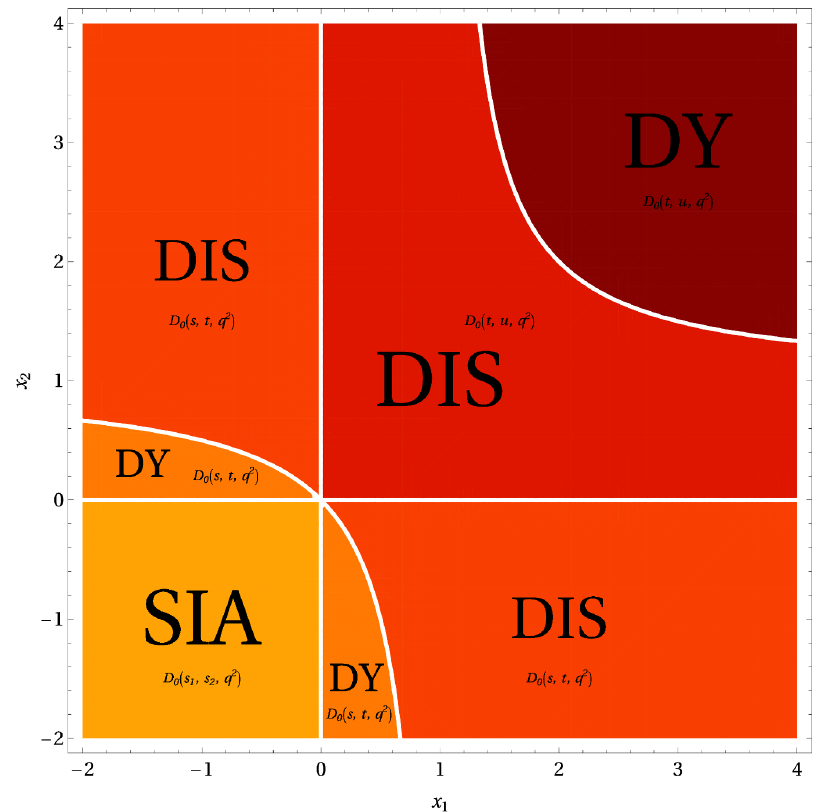
Figure 3 . Physical interpretation of the kinematic regions to be considered for the ε -expansion of D 0 ( ε ; x 1 , x 2 ) . For DIS and Drell-Yan, the Mandelstam variables are s > 0 , t < 0 , and u < 0 . In the case of SIA, all Mandelstam variables are positive. The virtuality q 2 of the off-shell particle is negative for DIS and positive for both Drell-Yan and